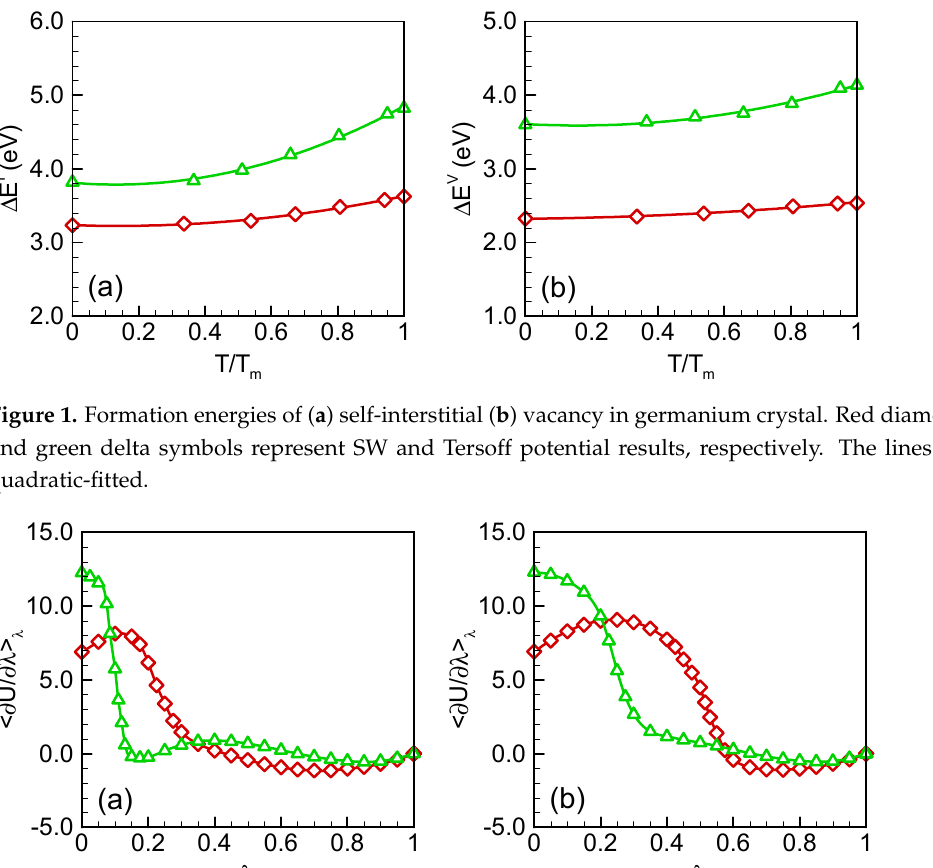
λ Figure 2. The integrands at different λ for ( a ) self-interstitial and ( b ) vacancy. Red for SW and green Figure 2. The integrands at different for ( a ) self-interstitial and ( b ) vacancy. Red for SW and green for Tersoff. The lines are guides for eyes. for Tersoff. The lines are guides for